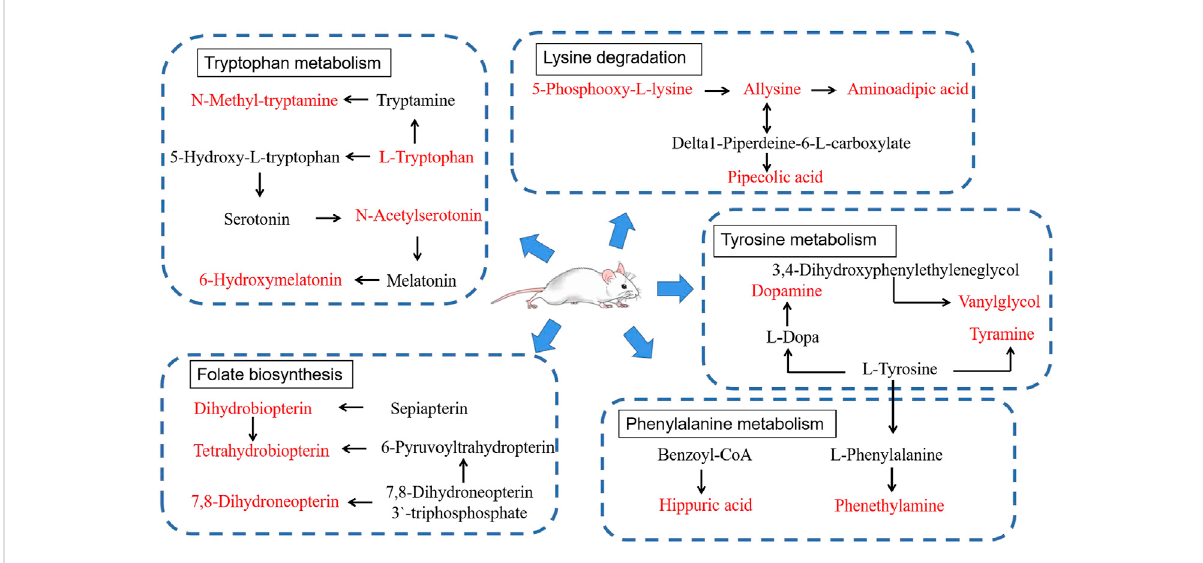
FIGURE 12 Main correlation network of potential biomarkers that CWT signi fi cantly reverses (red font represents potential